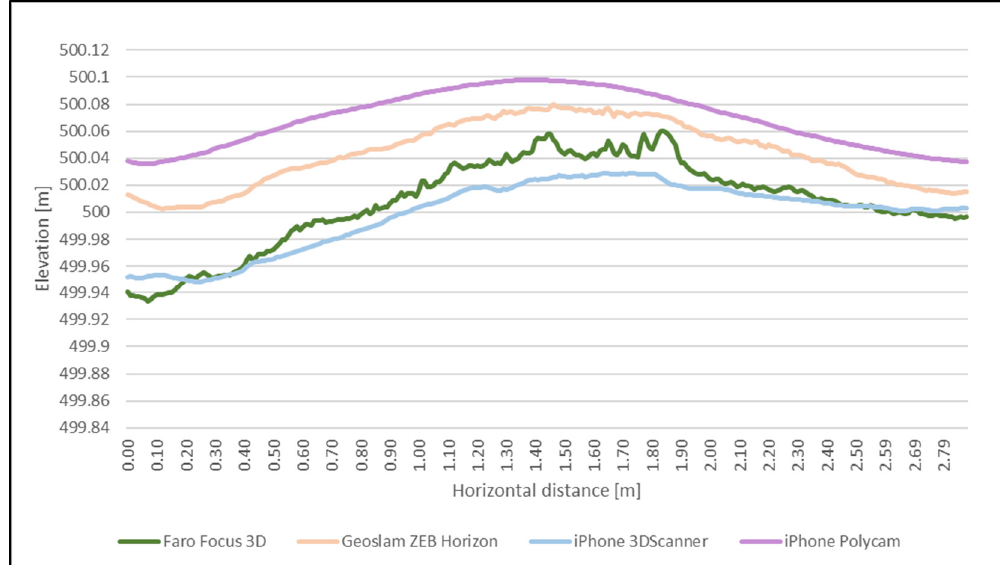
Figure 7. Cross profile example—road section No. 3. Table 5. Statistical evaluation of differences between digital surface models in comparison with ref- erence model from TLS scanner Faro Focus 3D.